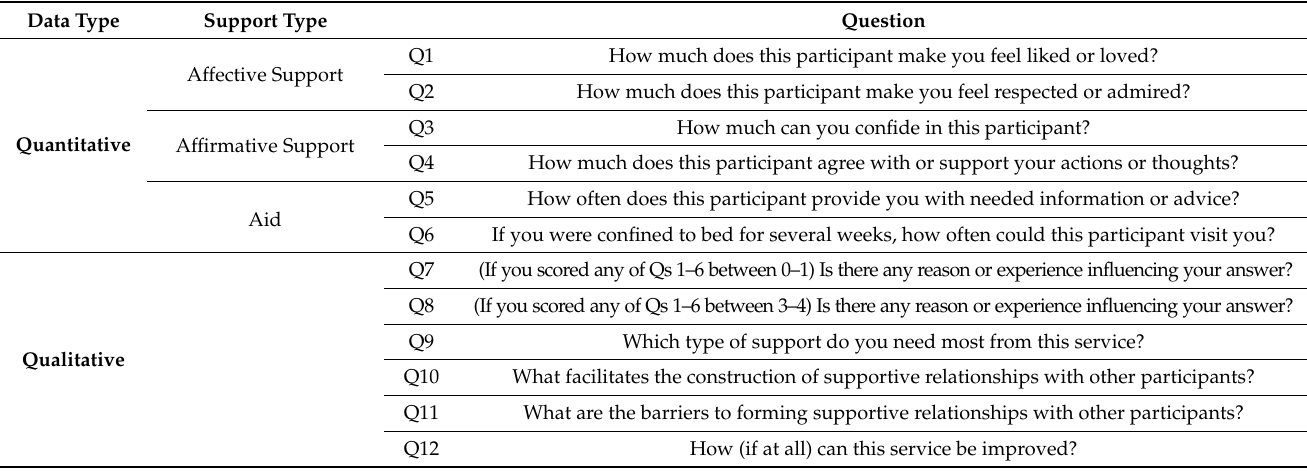
Table 1. Questionnaire for peer-support network analysis (Qs 7 or 8 were repeated for Qs 1 to 6 according to respondent scores). Data Type